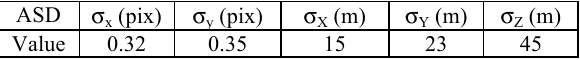
Table 1. Average standard deviations of tie points estimated in